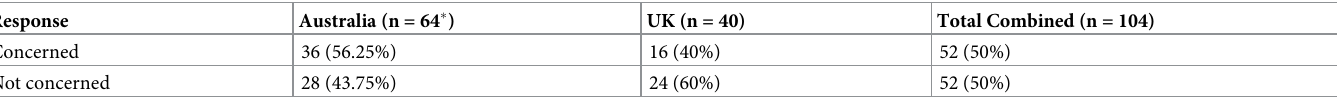
Table 5. The distribution of participants’ responses to the question, “How concerned are you personally about pharmaceuticals entering the natural environ- ment?”–environmental concern.